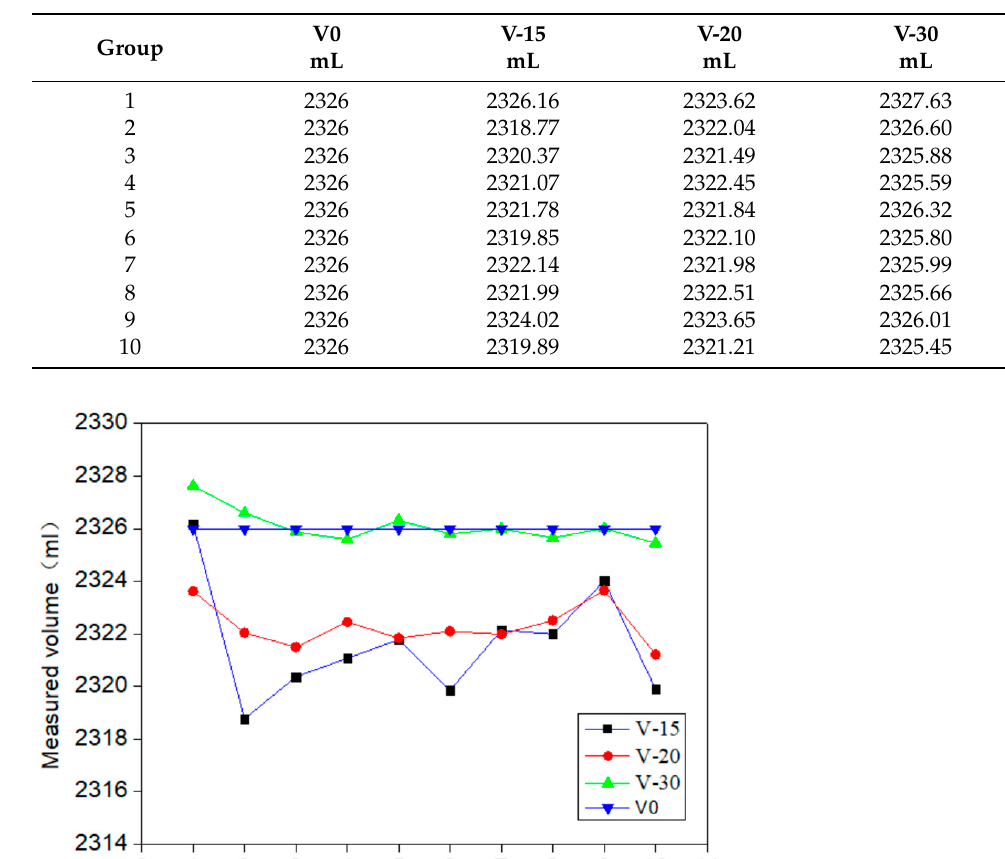
Table 1. Effect of gas equilibration time on volume detection, where V0 is the actual value of the volume, V-15 is the volume value detected when the gas equilibration time is 15 s, and V-20 and V-30 are also similar.